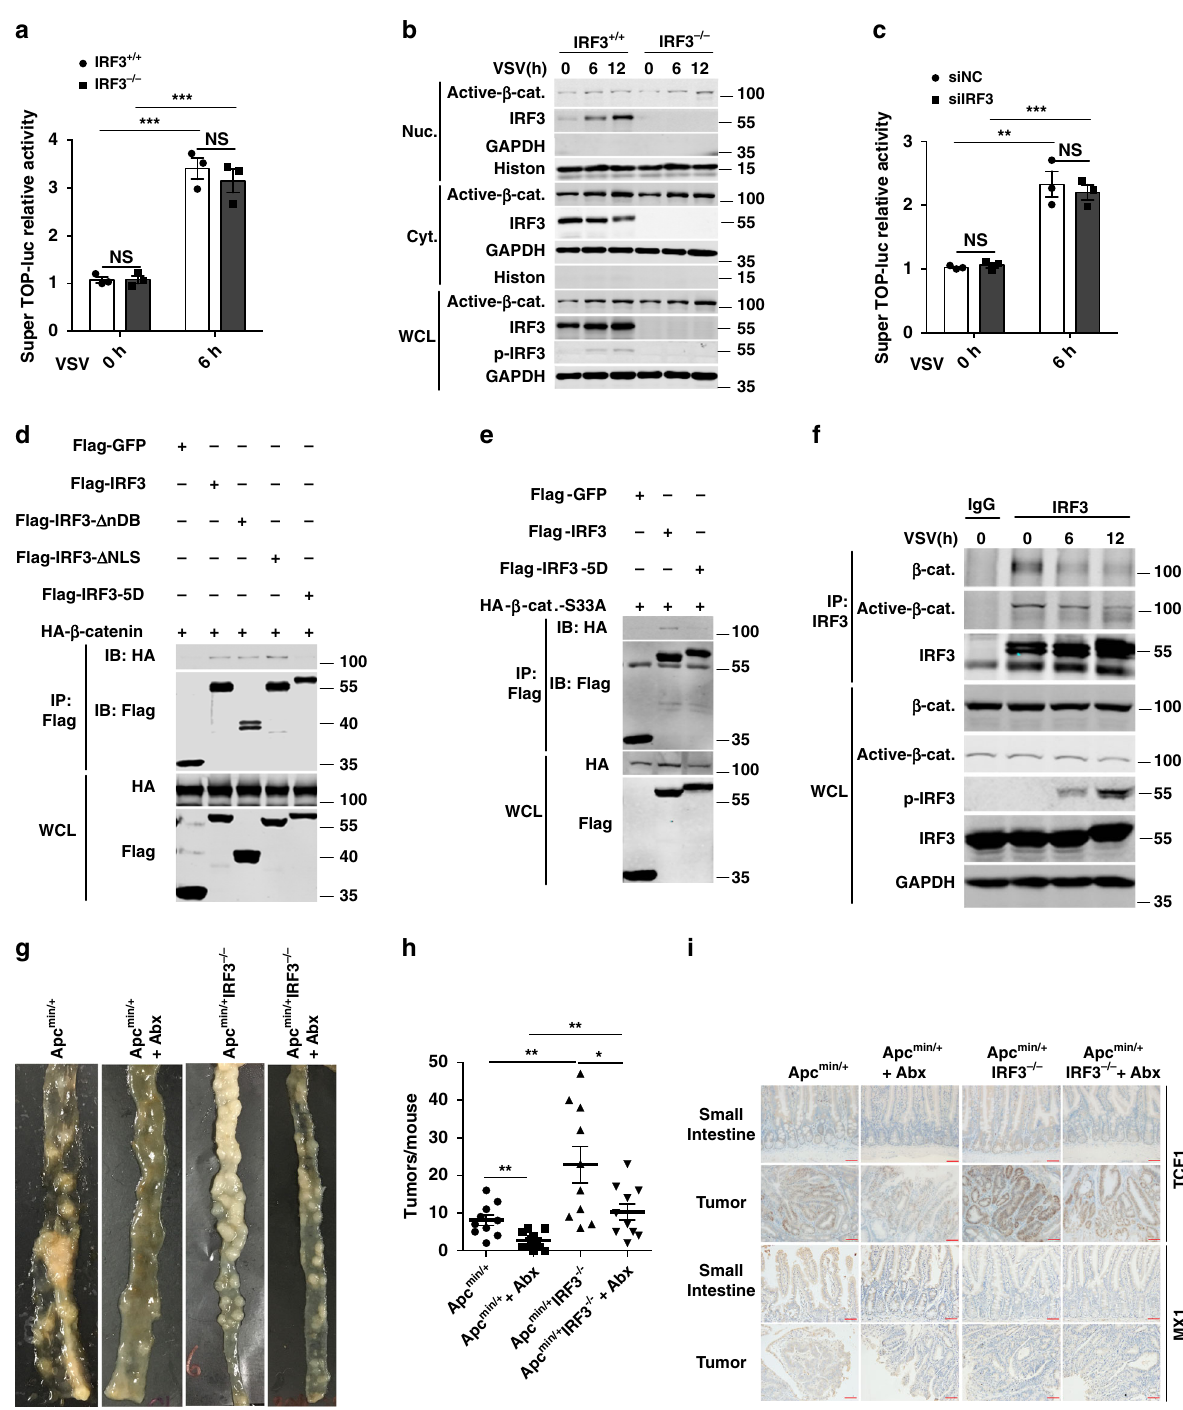
Fig. 6 Activation of IRF3 by PRR signaling relieves its inhibition on Wnt signaling. a TOP fl ash-relative luciferase activity analysis for VSV treatment in IRF3-knockout HCT116 cells. b Nucleocytoplasmic separation and immunoblot analysis of active- β -catenin (active- β -cat.) and IRF3 activation in HCT116 cas9 cells after treated with VSV. c TOP fl ash-relative luciferase activity analysis for VSV treatment in siNC and siIRF3 HCT116 cells. d Immunoblot analysis for the interaction between IRF3, IRF3- Δ nDB, IRF3- Δ NLS, or IRF3-5D and β -catenin with anti-FLAG immunoprecipitates of HEK293T cells. e Immunoblot analysis for the interaction between IRF3 or IRF3-5D and β -catenin-S33A with anti-FLAG immunoprecipitates in HEK293T cells. f Immunoblot analysis for the endogenous interaction between active- β -catenin or β -catenin and IRF3 with anti-IRF3 immunoprecipitates in HCT116 cell line extracts treated with VSV. g Representative images of the small intestine tumors from 5-month-old Apc min/ + and Apc min/ + IRF3 − / − mice with 4 months Abx treatment. h The small intestine tumor counts from Apc min/ + and Apc min/ + IRF3 − / − mice with Abx treatment ( n = 10, n = 11, n = 10, n = 10). i Standardized TCF1 and MX1 immunostaining of the small intestine and tumors from Apc min/ + and Apc min/ + IRF3 − / − mice with Abx treatment or without Abx treatment. Scale bars, 50 μ m. Each symbol represents one mouse ( h ). * P < 0.05; ** P < 0.01; *** P < 0.001; NS not statistically signi fi cant by two-tailed t test ( a , c , h ). Data are from two ( g – i ) or three ( a – f ) independent experiments and are presented as mean ± s.e.m. in a , c , h . Source data are provided as a Source data fi le. See also Supplementary Fig.